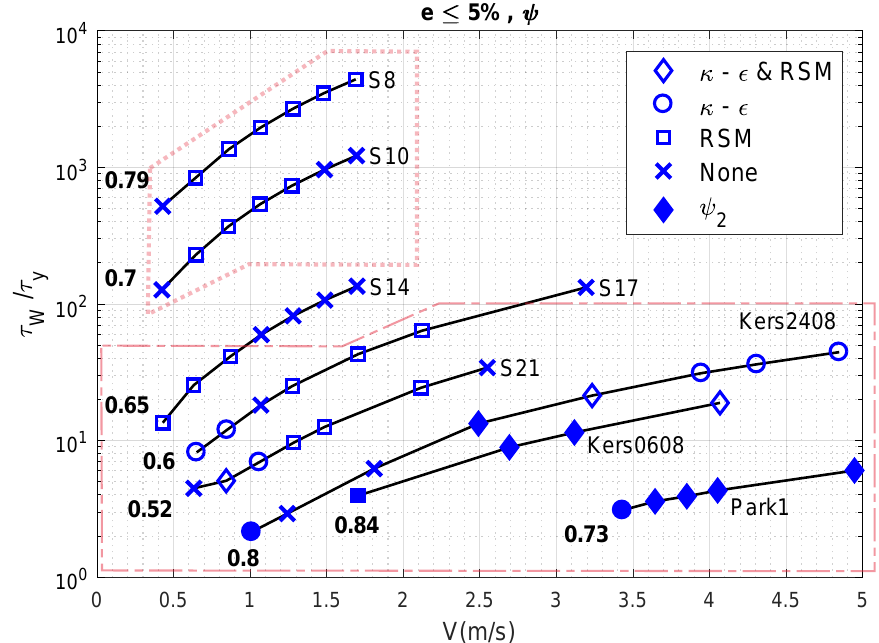
Figure 10. Performance of the standard RANS models combined with ψ 1 to achieve an error e ≤ 5%.